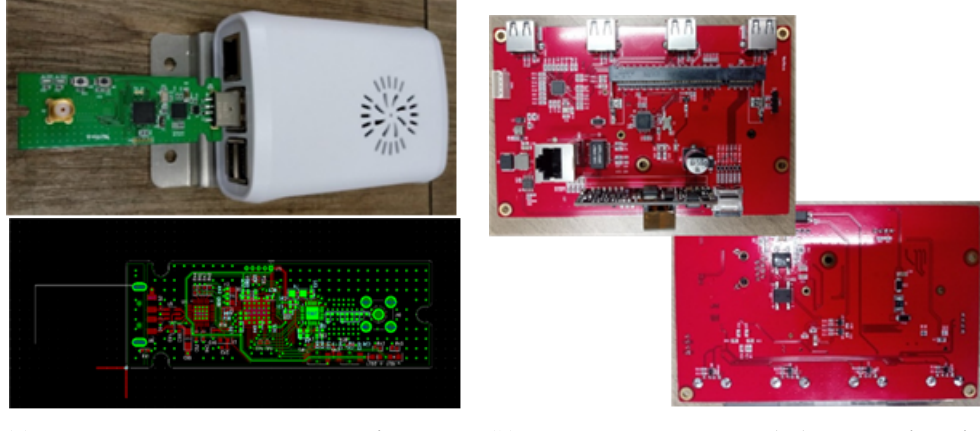
Figure 6. The hardware platforms for